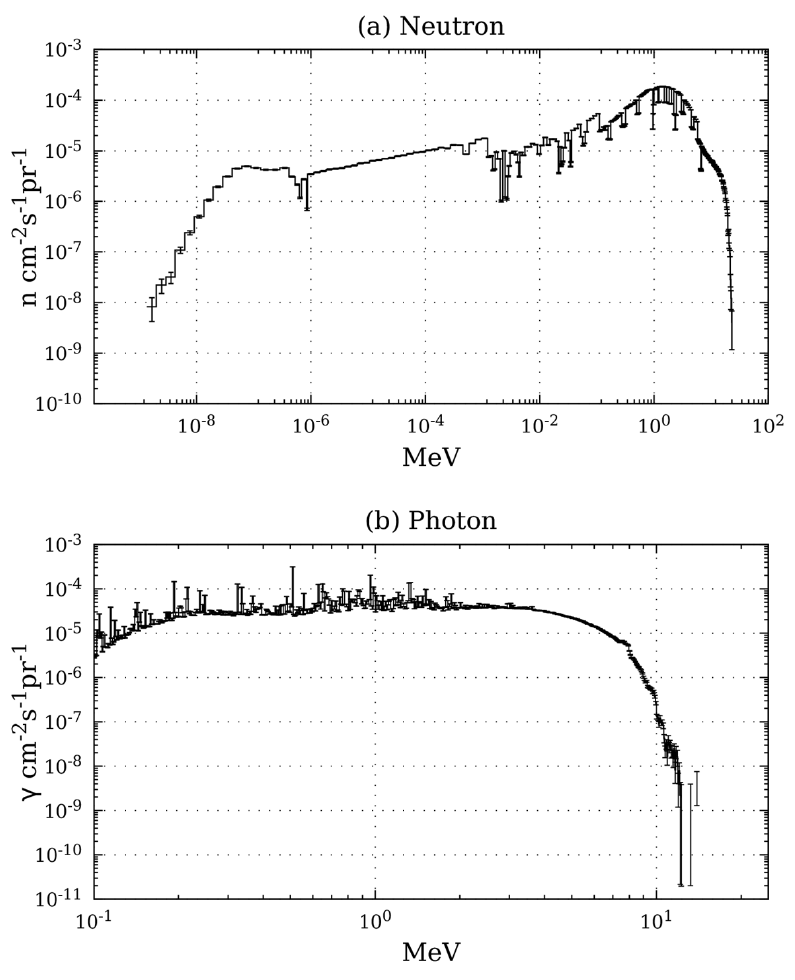
Figure 7. Neutron and photon fluences generated during the irradiation of 100 Mo target using a 24 MeV proton beam with intensity of 500 µ A.